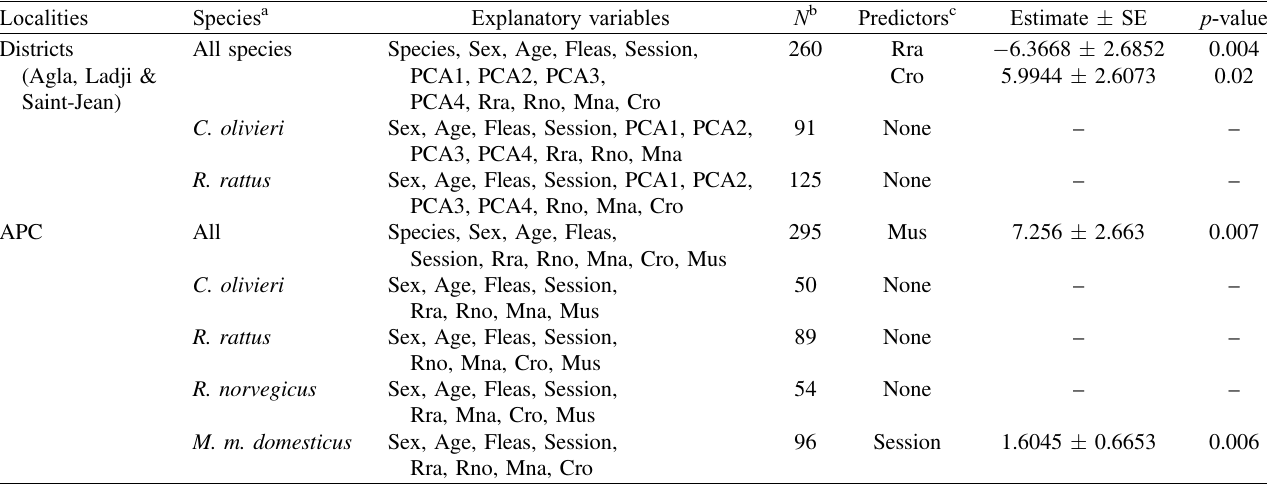
Table 2. Results of Generalized Linear Mixed Models (best models) explaining T. gondii infection of main rodent host species in the sampled districts. Rra, Rno, Mna, Cro, Mus represent Rattus rattus , Rattus norvegicus, Mastomys natalensis, Crocidura olivieri and Mus musculus domesticus yield, respectively; Fleas: presence of fl eas on the individual. Session: trapping session. PCA 1 – 4: PCA sites coordinates of axis 1 –